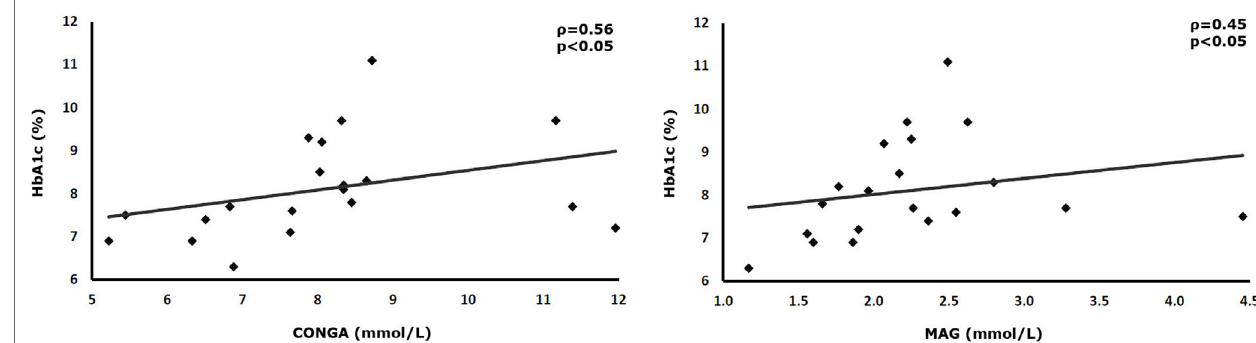
FigUre 3 | Correlations between glucose variability parameters and